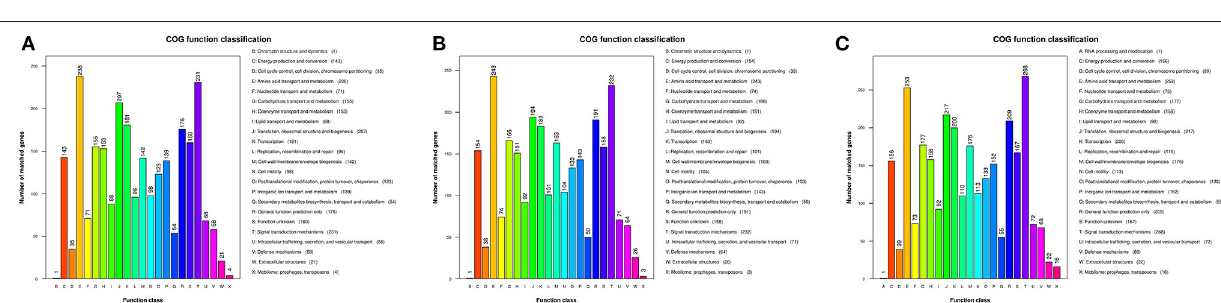
FIGURE 3 | Phylogenetic analysis of V. metschnikovii strain genomes. Different colored blocks are used to indicate types and groups of strains on the left of phylogenetic tree. The color legend is shown below the phylogenetic tree.